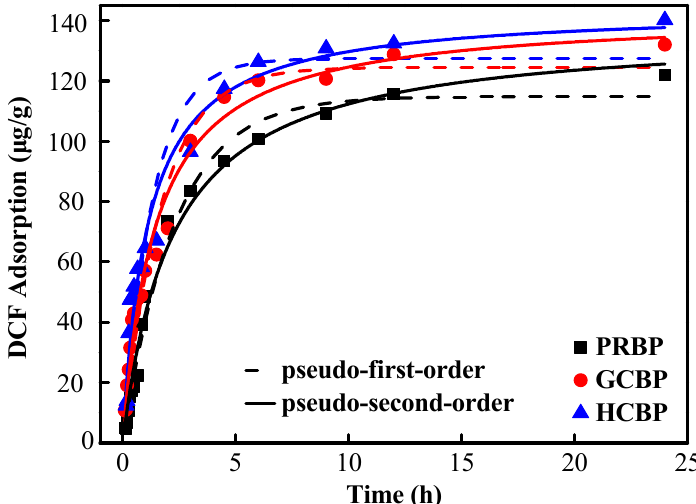
Figure 4. The adsorption kinetic of diclofenac (DCF) onto PRBP, GCBP, and HCBP. Experimental